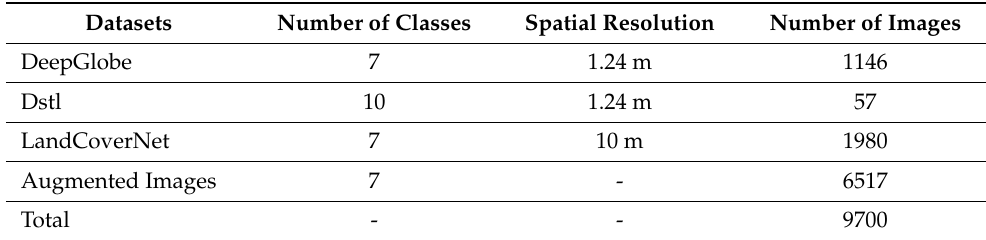
Table 2. Comparison of main the characteristics of the abovementioned datasets such as DeepGLobe, Dstl and LandCoverNet. Datasets Number of Classes Spatial Resolution Number of Images DeepGlobe